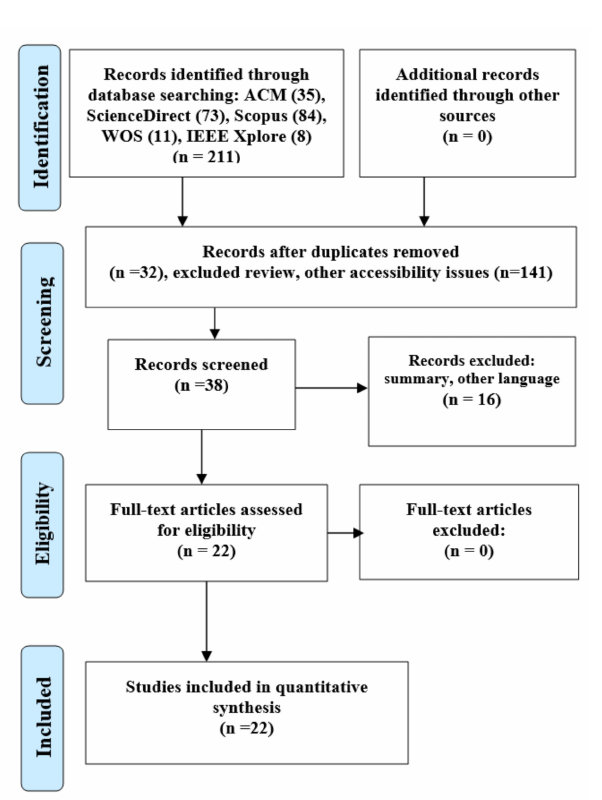
Figure 2. PRISMA flow diagram for the scoping review